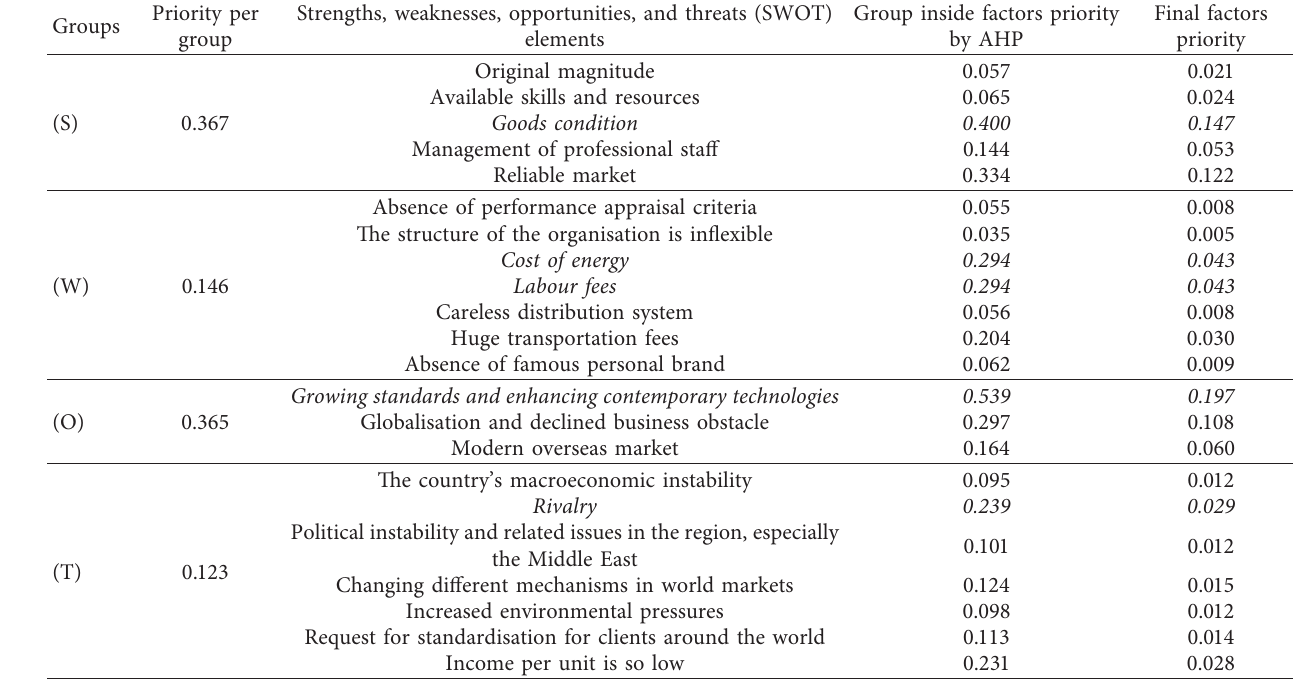
Table 9: Final priority rescores of SWOT elements via AHP.